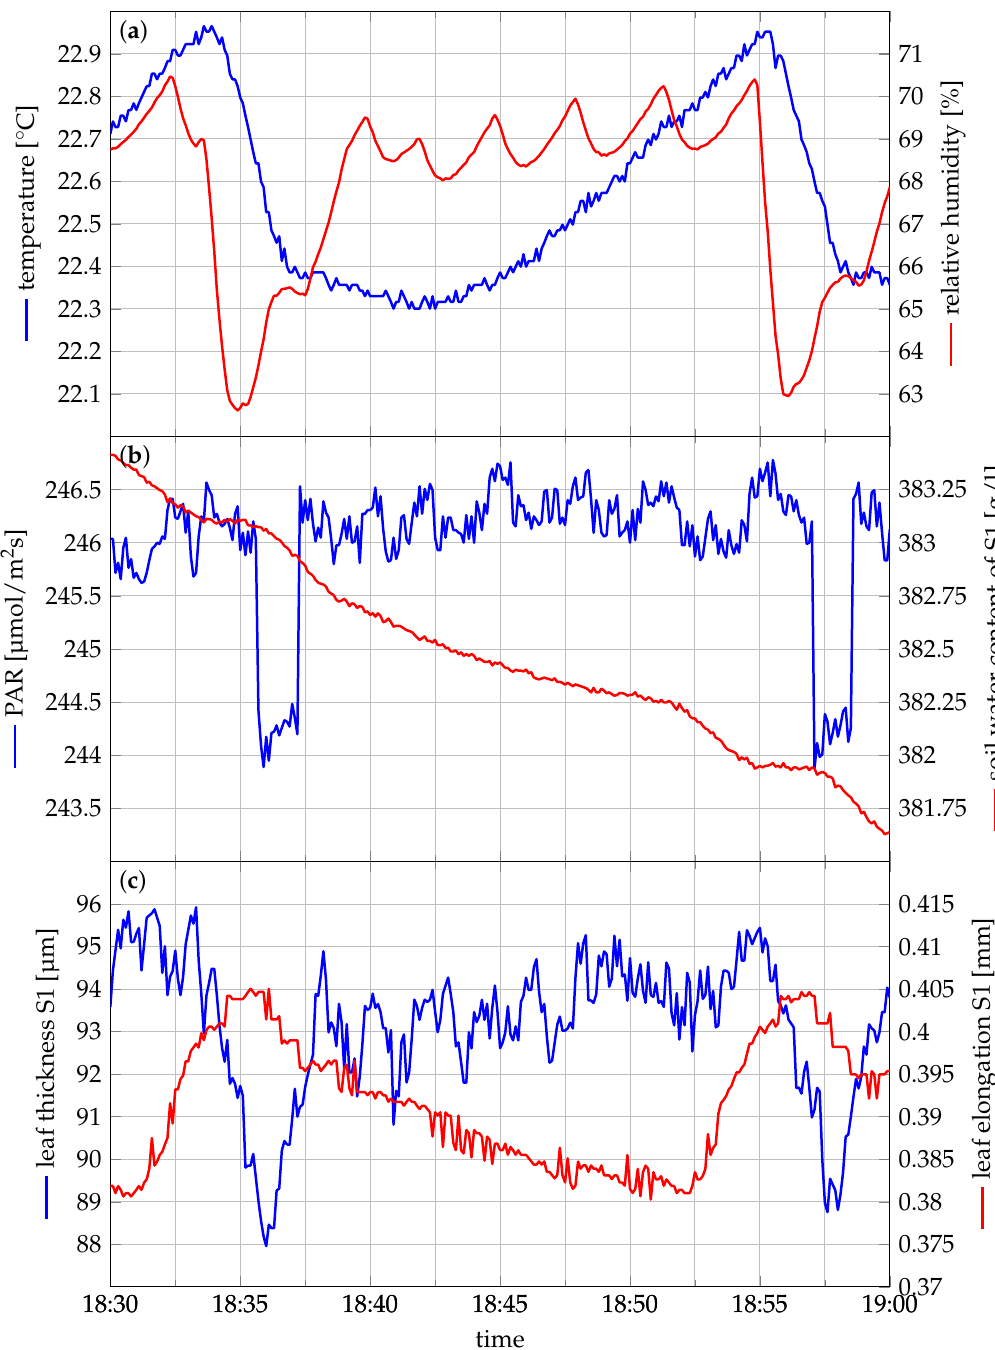
Figure 8. Detail figure of the grey shaded in Figure 7 to visualise of the accuracy of the system. Only the leaf thickness and leaf length of S1 are plotted since there is a significant offset between the leaf thickness of S1 and S2 and leaf length of S1 and T in Figure